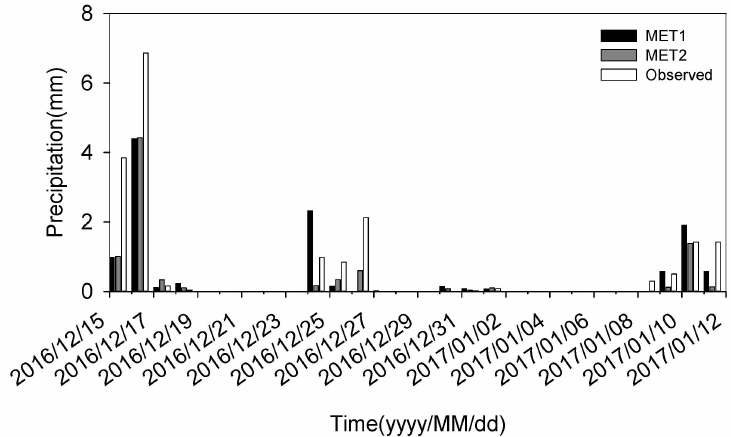
Figure 6. Histogram of hourly the 24 h averages of the observed precipitation (unit: mm) from 15 December 2016 to 11 January 2017 (white bar) and simulated precipitation of MET1 (black bar) and MET2 (grey